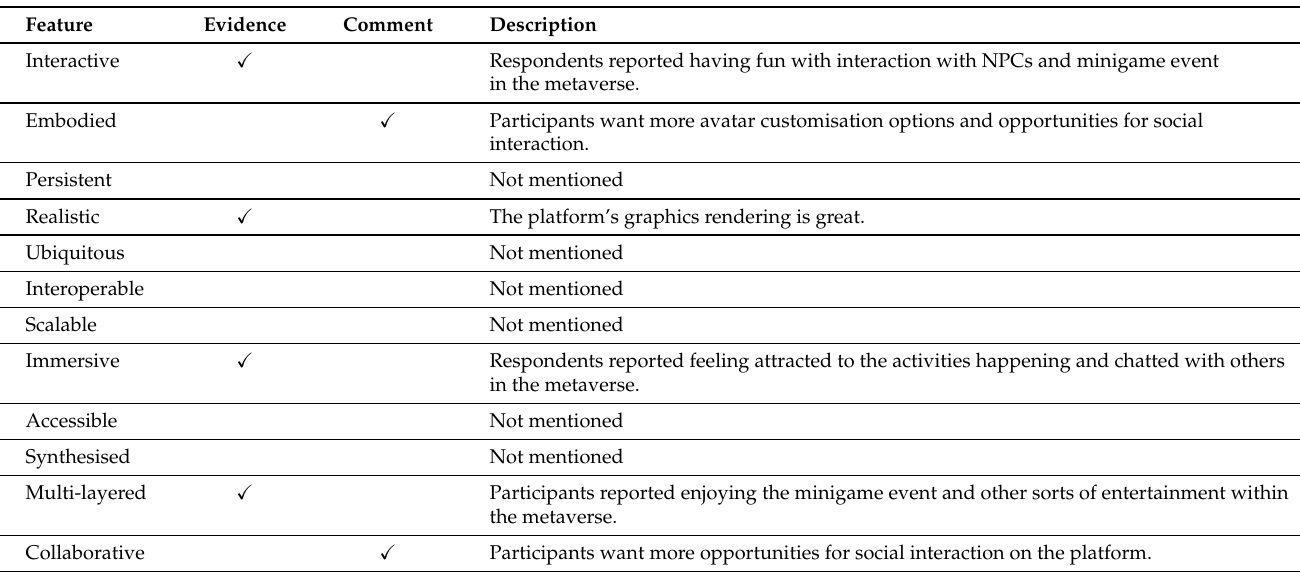
Table 10. Evidence or comments from the results related to the key metaverse features.